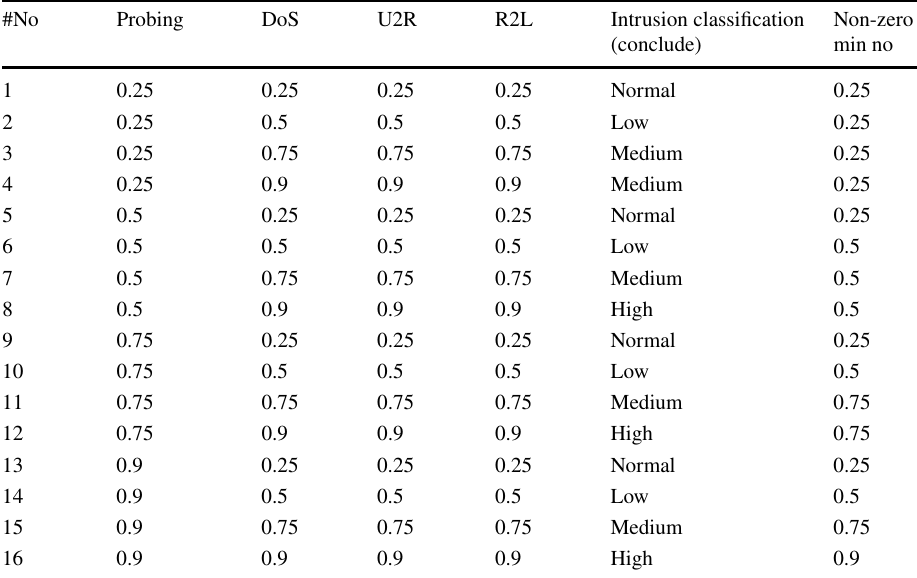
Table 3 Sample rule